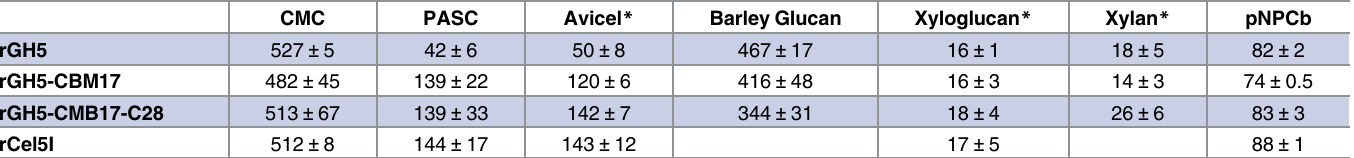
Table 1. Specific activities of the various forms of Cel5I on different